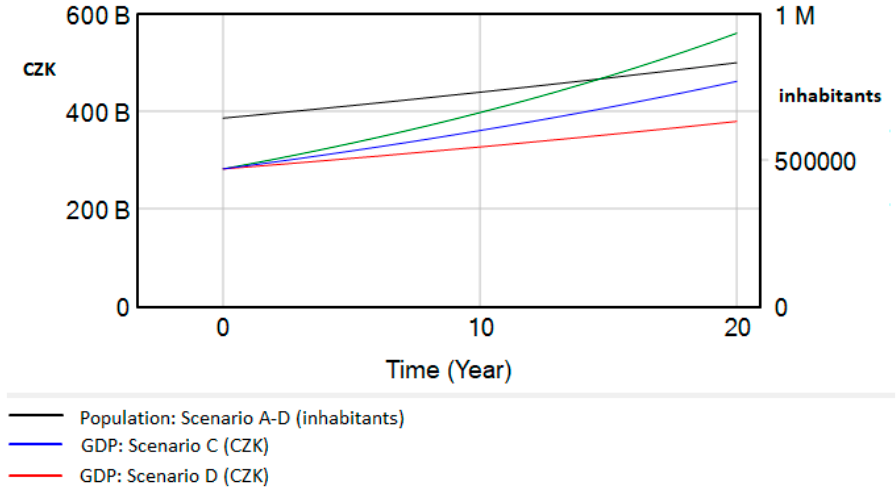
Figure 8. GDP and population trends over the 20 years.